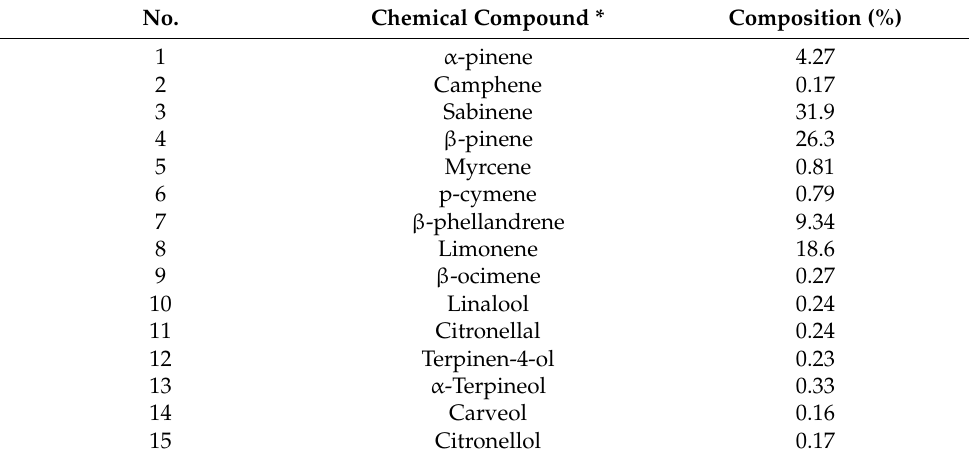
Table 1. Chemical composition of kaffir lime peel essential oil.